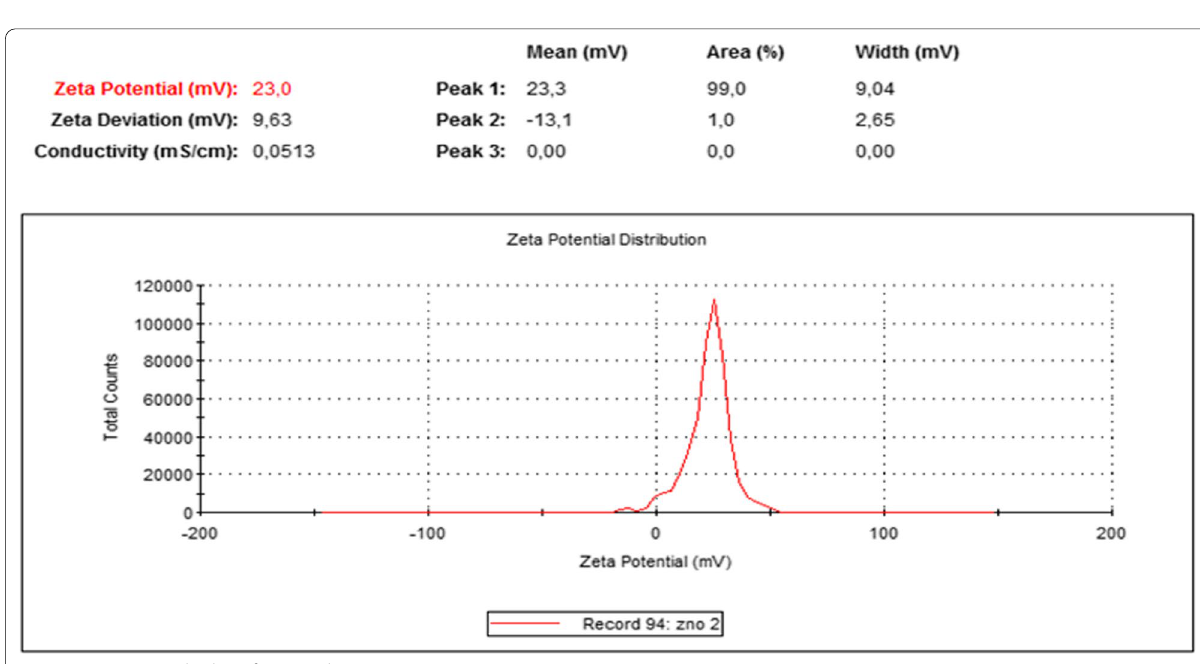
Fig. 2 Zeta potential value of zinc oxide